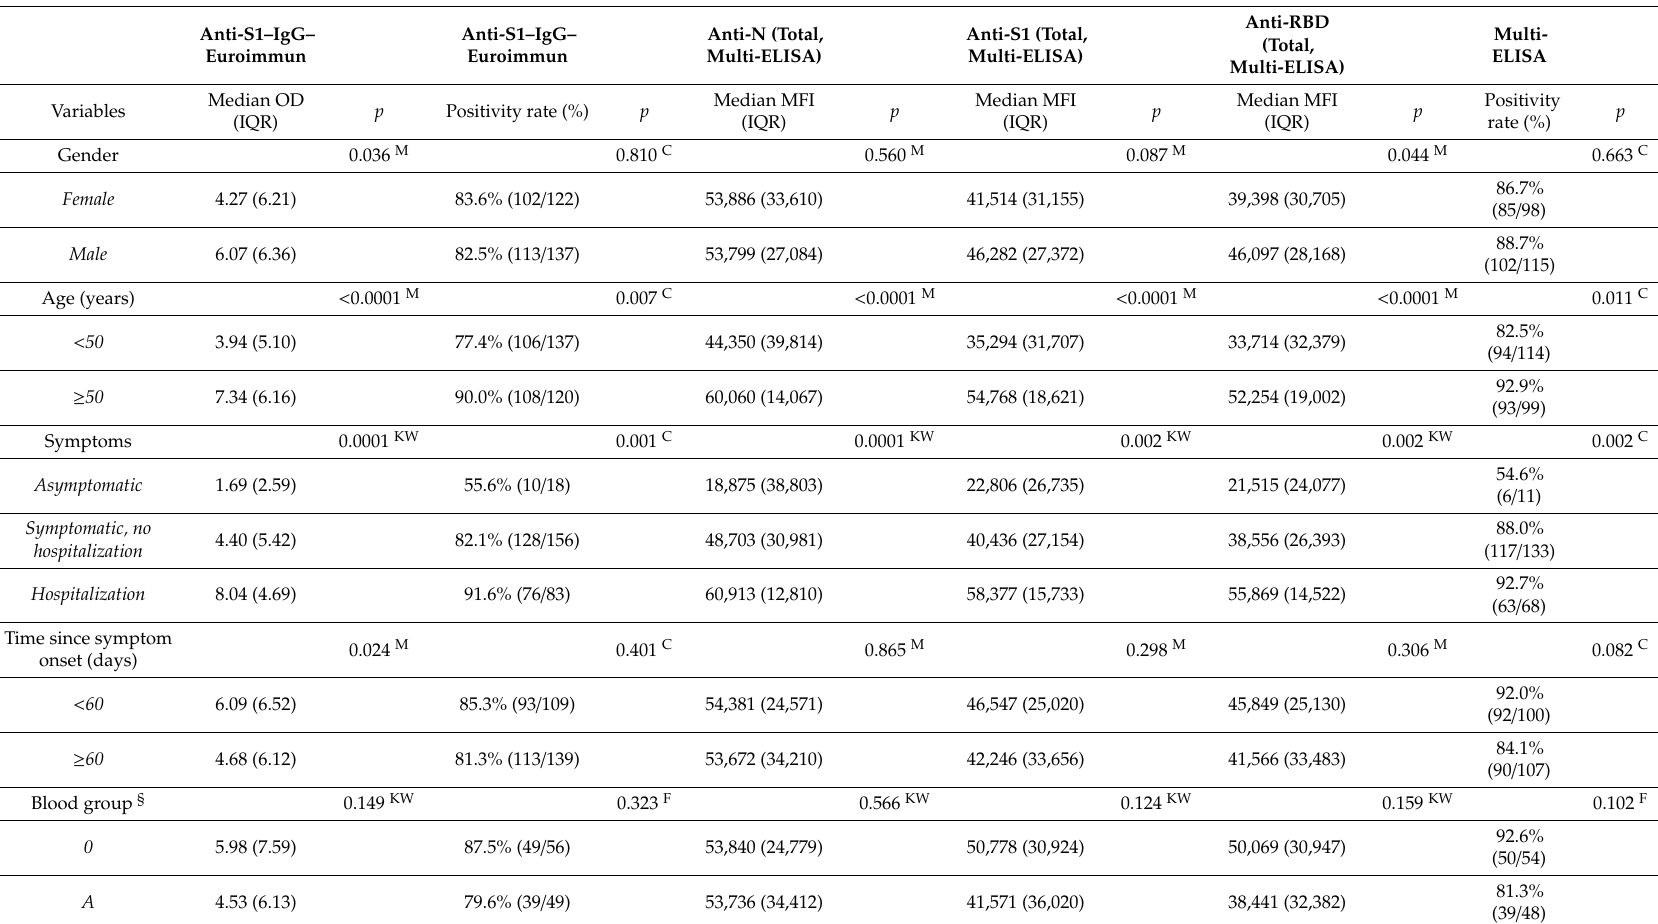
Table 3. Results of the univariate analysis examining associations between anti-SARS-CoV-2 antibody levels and demographic-clinical variables. Multi-ELISA was performed in 213 of 259 patients in the cohort. Bold cells denote statistically significant